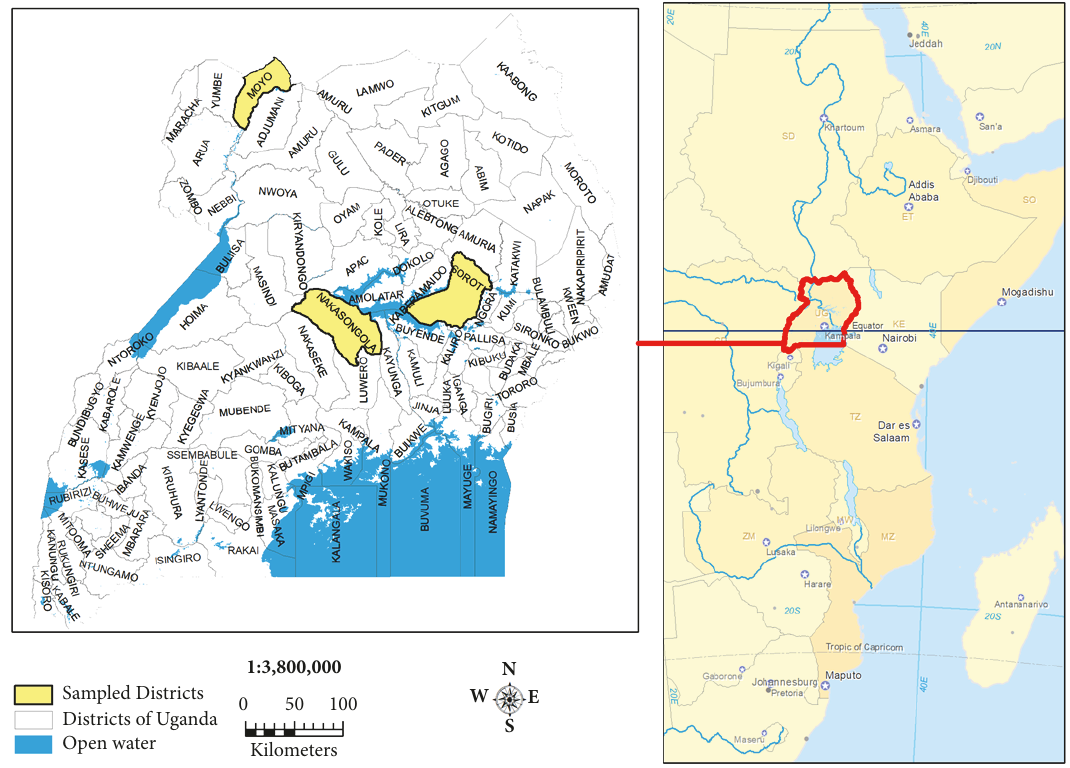
Figure 1: Map of Uganda showing sample sites in different agroecological